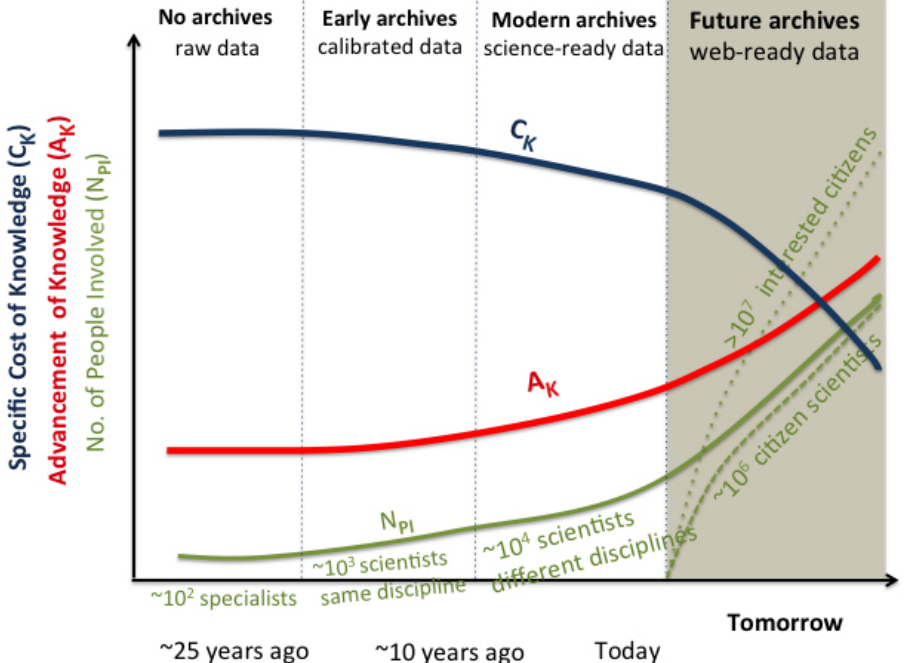
Figure 1. Conceptual timeline of the evolution of data archives in Astronomy. Taken from the original Open Universe proposal